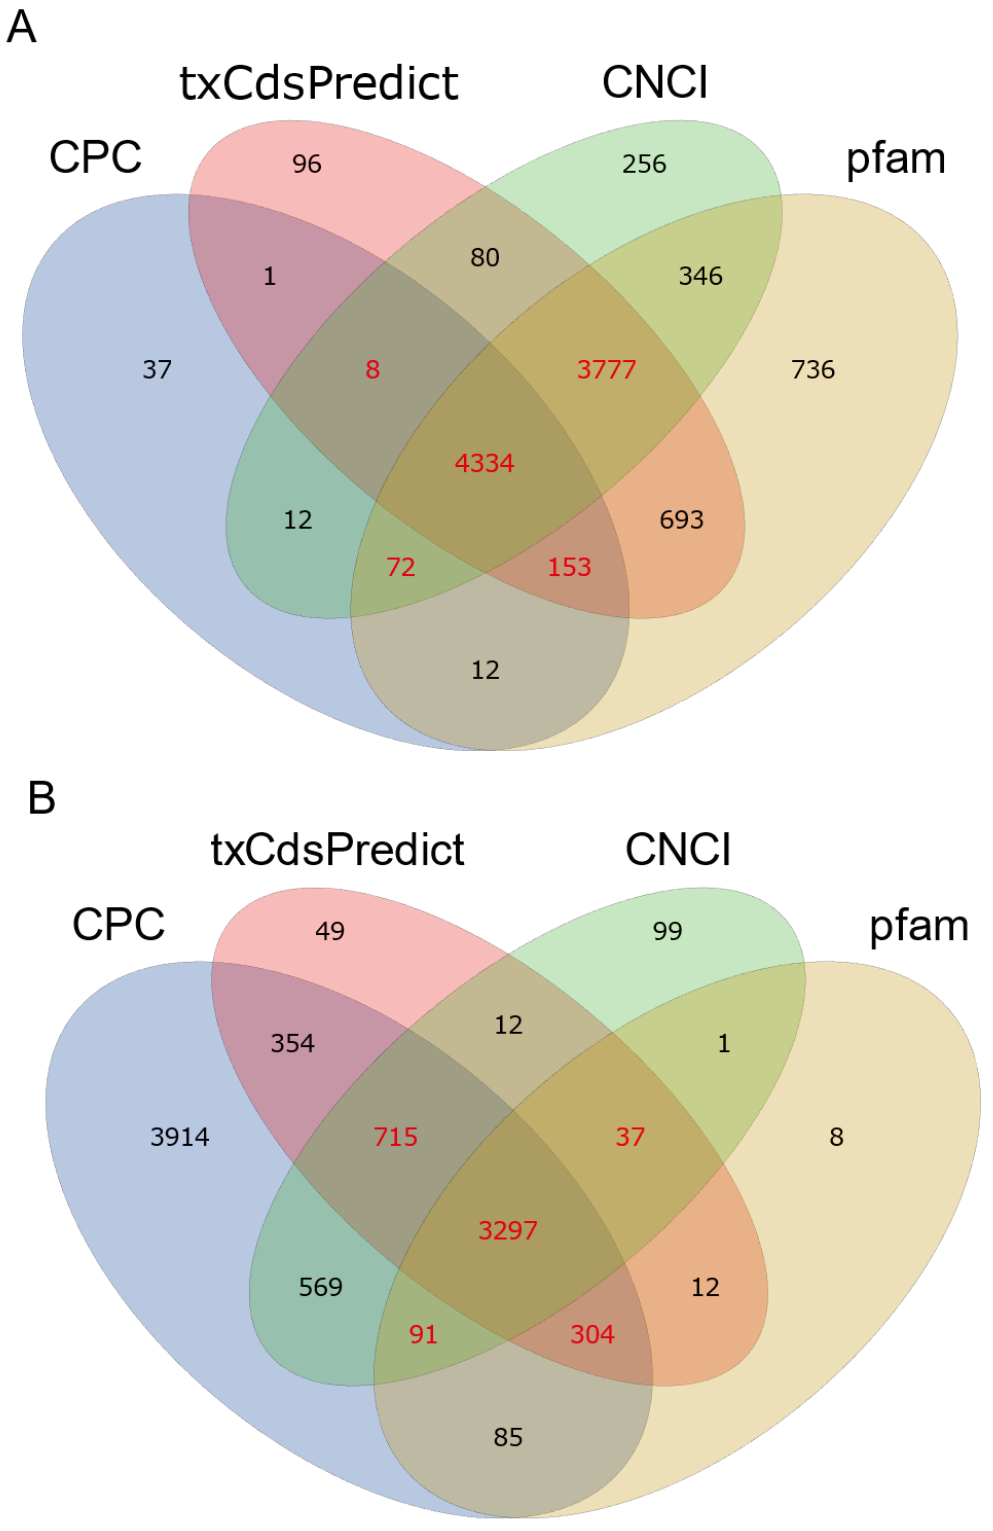
Figure 1. Venn diagram of the novel lncRNAs ( A ) and mRNAs ( B ) by coding capacity analysis using four methods. CPC: Coding Potential Calculator; txCdsPredict: part tool of UCSC Genome Browser; CNCI: Coding-Noncoding Index; pfam: Pfam database. Specific LncRNAs and mRNAs were identified if consistently discovered by at least three of the methods and are shown in red.